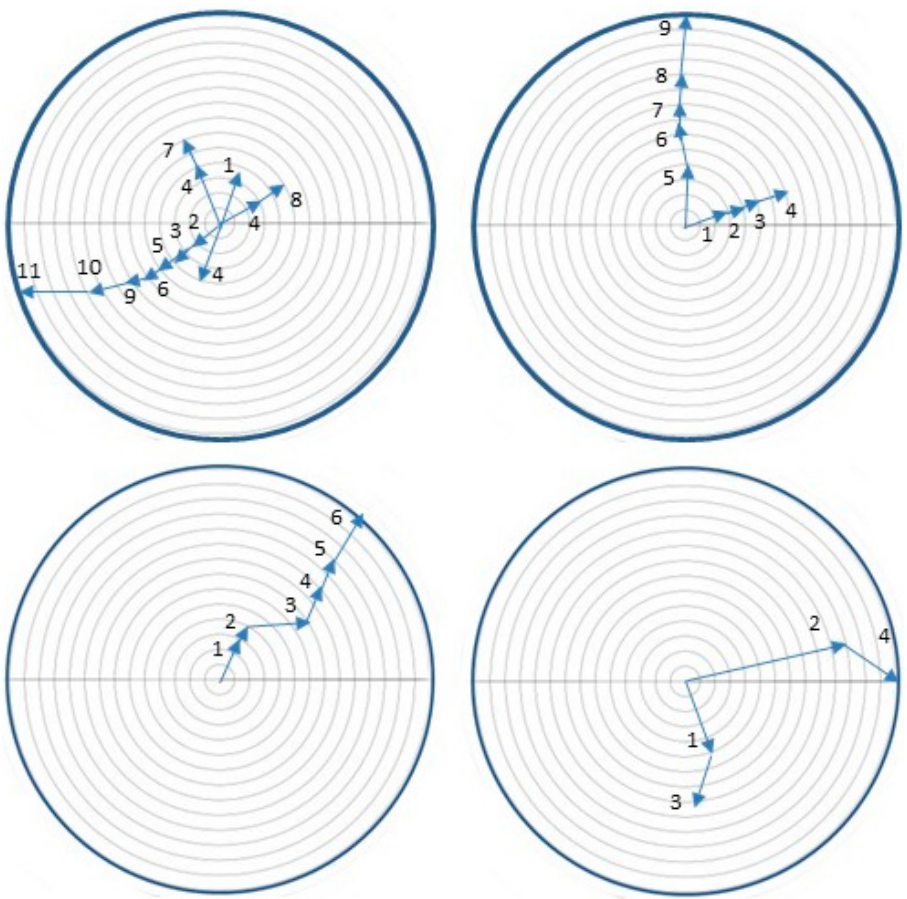
Figure 9. Representative examples of trail marking by colonies of Cactoblasts cactorum caterpillars abandoning egg sticks attached to paper arenas.